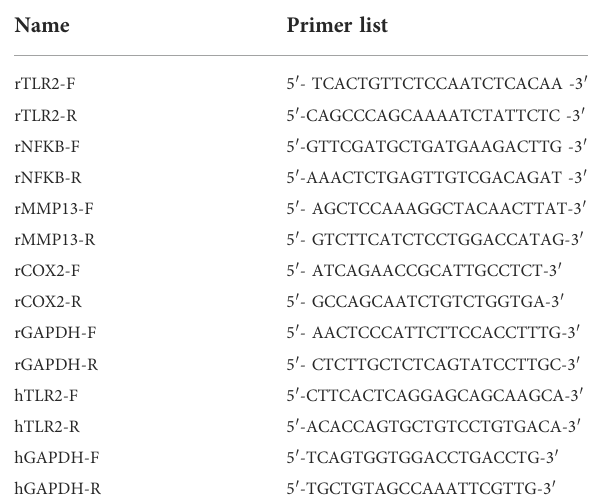
TABLE 1 The primers of